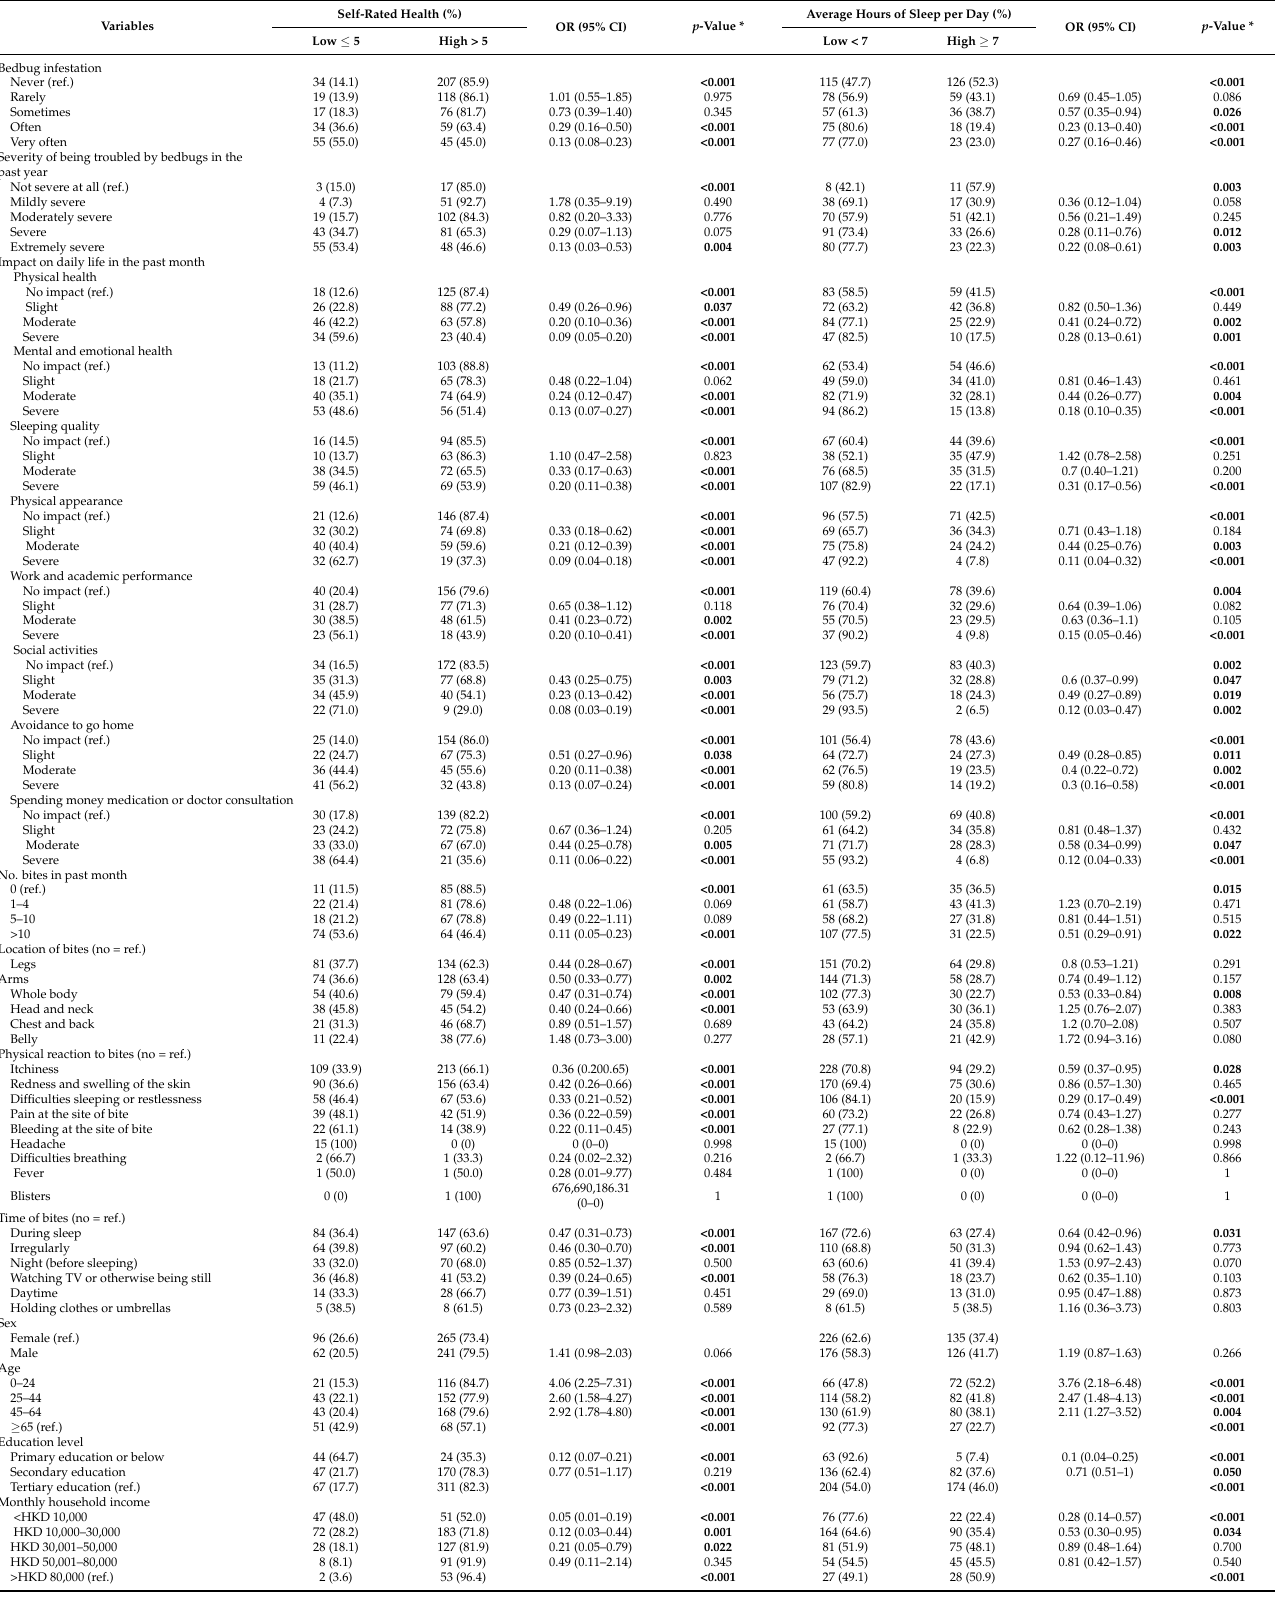
Table 2. Bivariate analysis of survey responses by self-rated health and average hours of sleep per